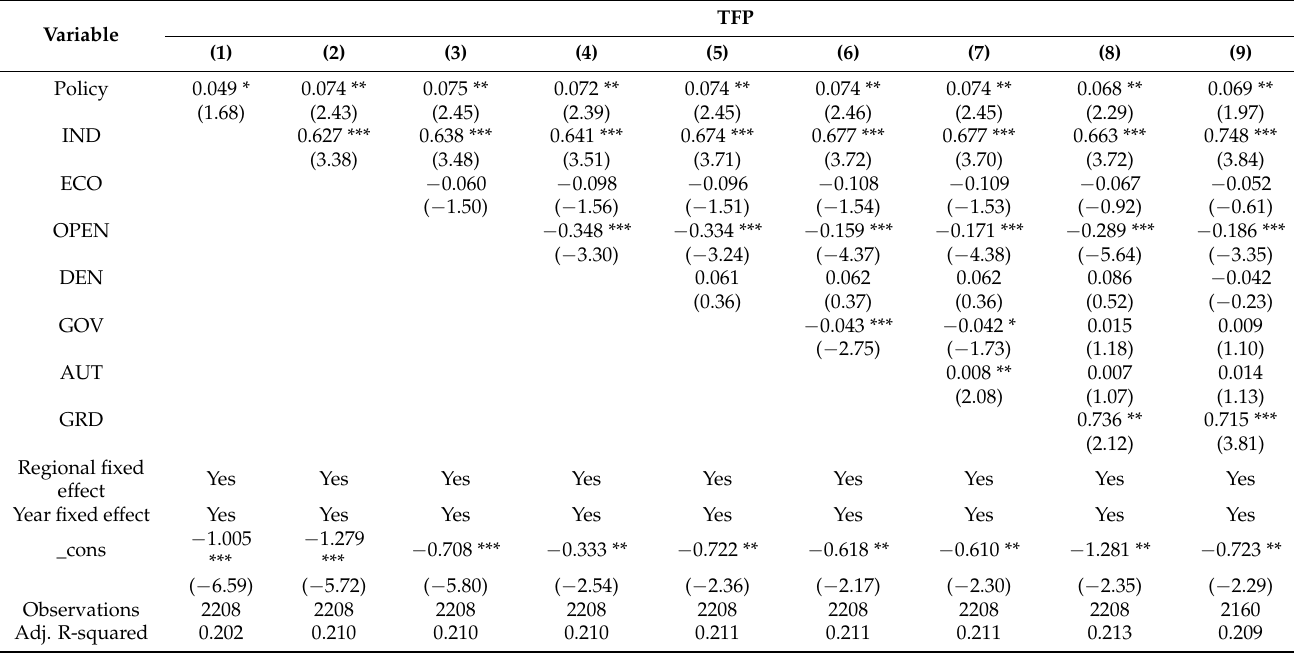
Table 3. Effects of low-carbon city construction (LCC) on the total factor productivity (TFP). Variable